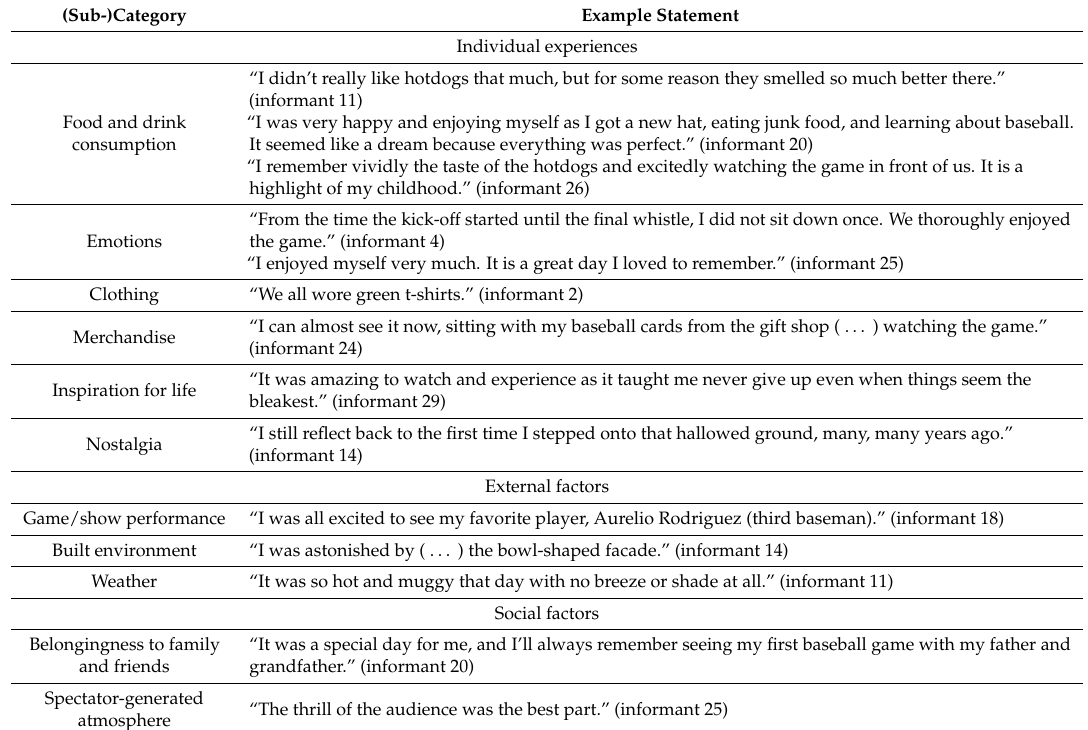
Table 1. Categories of childhood memories about the attendance of sporting